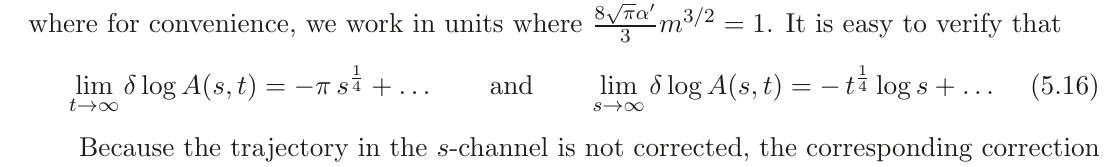
Figure 5 . The correction to the distribution in the t -channel has two supports. One is an horizontal distribution, ρ t,h . It is bounded inside the unit circle and is of indefinite sign. The other is a vertical distribution, ρ t,v . It is a strictly positive distributed that is diffused along the line β = s/t = 1 / 2 + iy and goes all the way to −